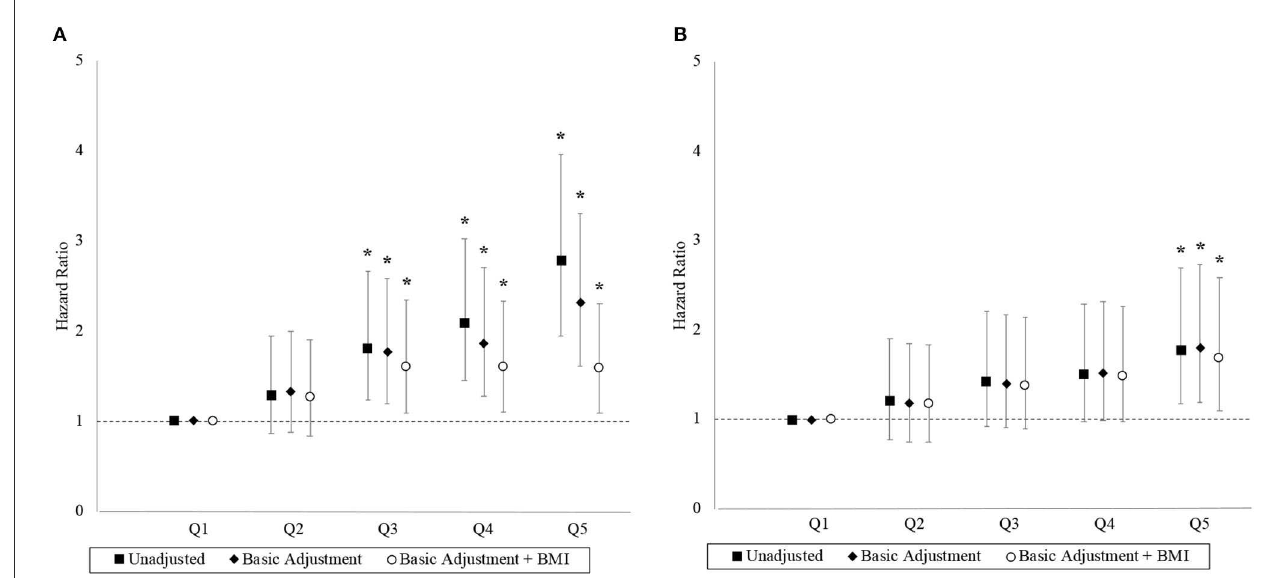
FIGURE2 Hazard ratios with 95% confidence interval by run-time quintile. Panels (A, B) correspond to the MACE and ACM outcomes, respectively. Basic adjustments also included the year of BMI measurement and age at time of entry into the study period as predictors in the models. The models were further adjusted for BMI. An asterisk (*) denotes a hazard ratio that is significantly different from 1 (i.e., p < 0.05).